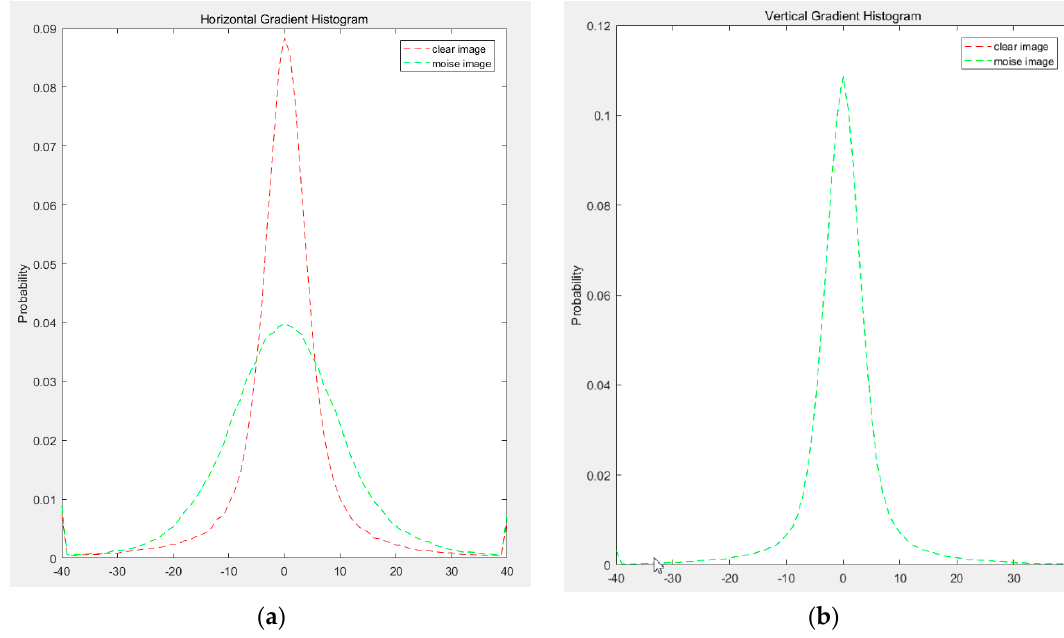
Figure 8. Gradient probability distribution. ( a ) Horizontal gradient probability distribution; ( b ) vertical gradient probability distribution (x coordinates: horizontally or vertically gradient; y coordinates: probability distribution).